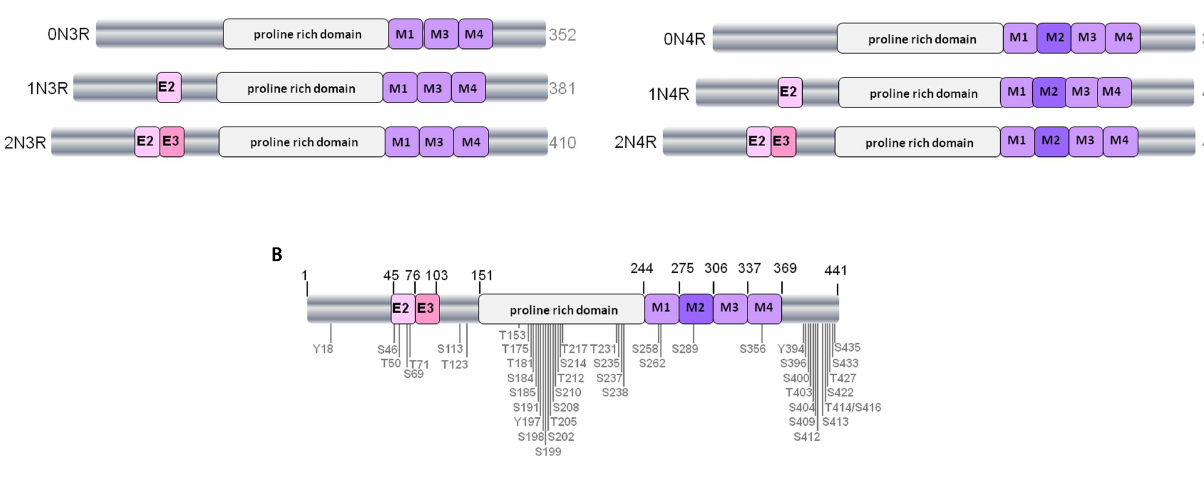
and M2 inclusion results in 4R tau isoforms.The proline-rich domain in the center of the tau polypeptide is indicated. Alternative-splicing produces tau isoforms of 352–441 amino acids, as indicated. (B) Positioning of phosphorylation sites on tau from Alzheimer brain. Approximately 45 phosphorylation sites have been identified, these are found predominantly in the proline-rich domain and the regions flanking the microtubule-binding